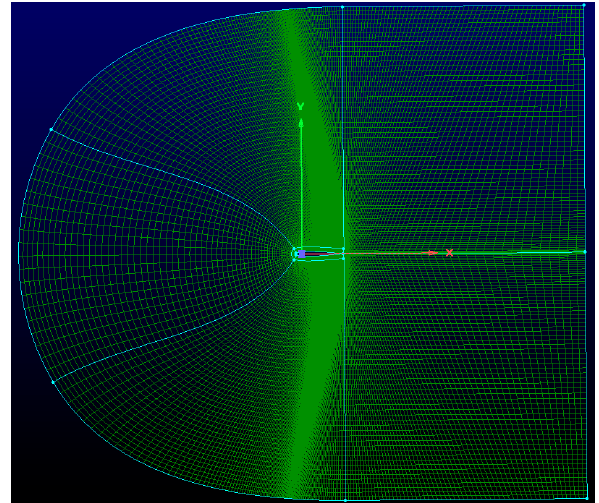
Figure 18. Automated generation of high-quality meshes.